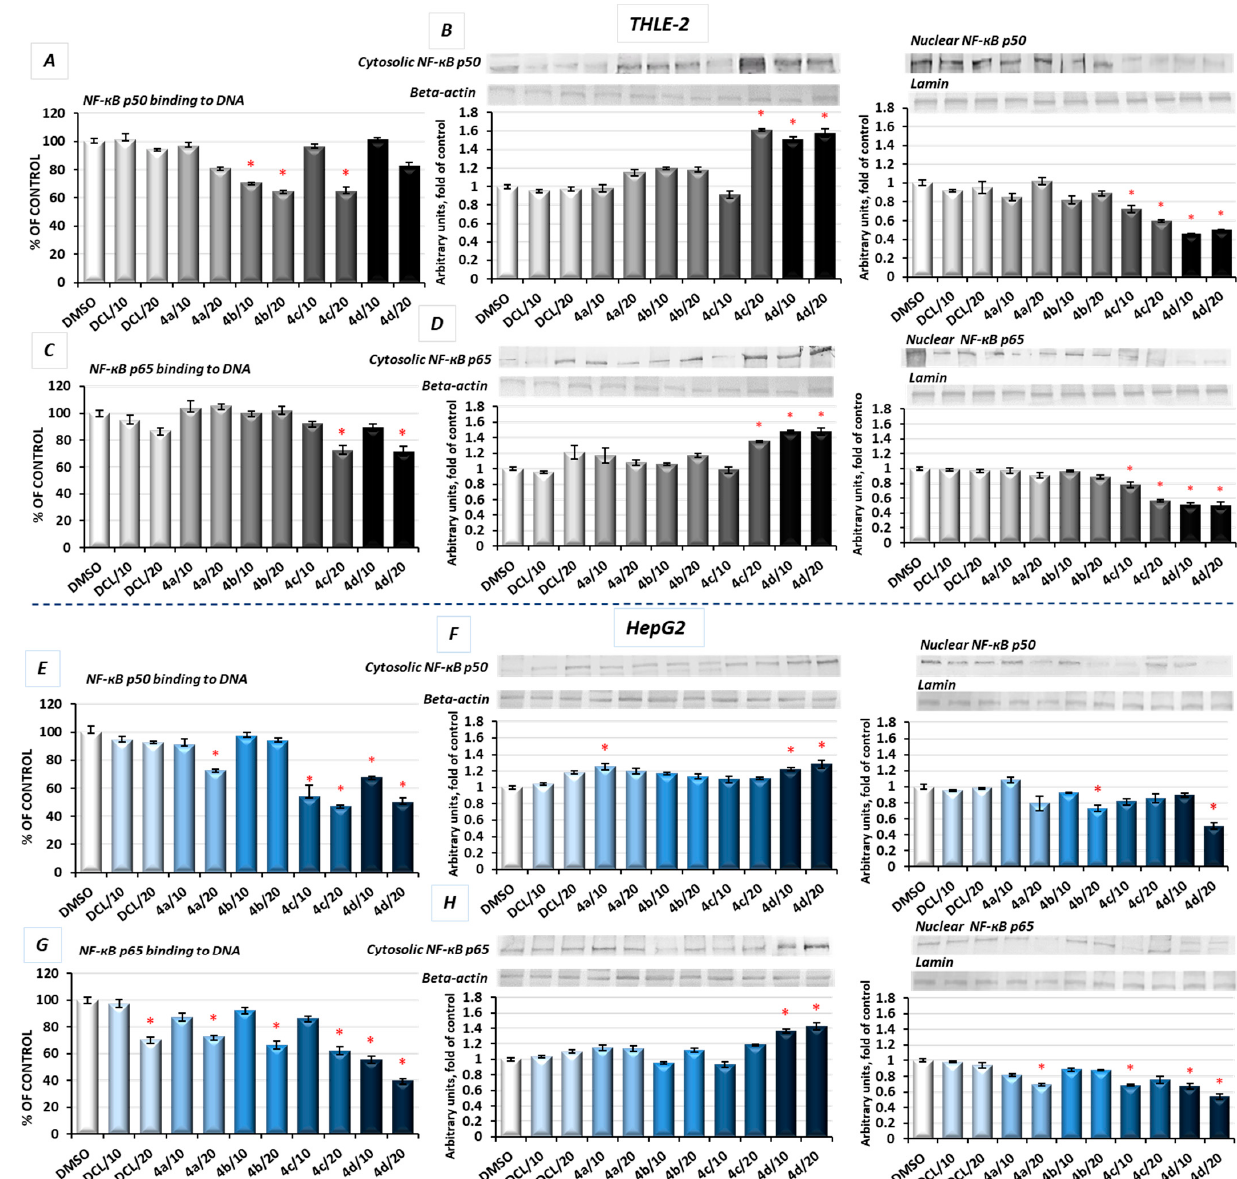
Figure 6. The effect of DCL and DCL–OAO derivative conjugates ( 4a – 4d in 10 and 20 µ M concentrations) on the NF- к B p50 and NF- к B p65 binding to DNA and translocation from the cytosol to the nuclei in the THLE-2 cells ( A – D ) and HepG2 cells ( E – H ) after 24 h incubation. Activated NF- к B p50 and NF- к B p65 were assessed in terms of the amount of NF- к B p50 ( A , E ) and NF- к B p65 ( C , G ) contained in the DNA-binding complexes extracted from the nuclear fraction. The values (mean ± SEM) were calculated from three separate experiments as protein levels in comparison to control cells set to 100%. Representative immunoblots for the analysis of the cytosolic and nuclear levels of proteins NF- к B p50 ( B , F ) and NF- к B p65 ( D , H ) are shown. The sequence of the bands corresponds to the sequence of the bars in the graph. Lamin and β -actin were used as a loading control. The values were calculated as protein levels in comparison to control cells set to 100%. * Significantly different from control—DMSO-treated cells, p < 0.05. Statistical significance was assessed by Student’s- t